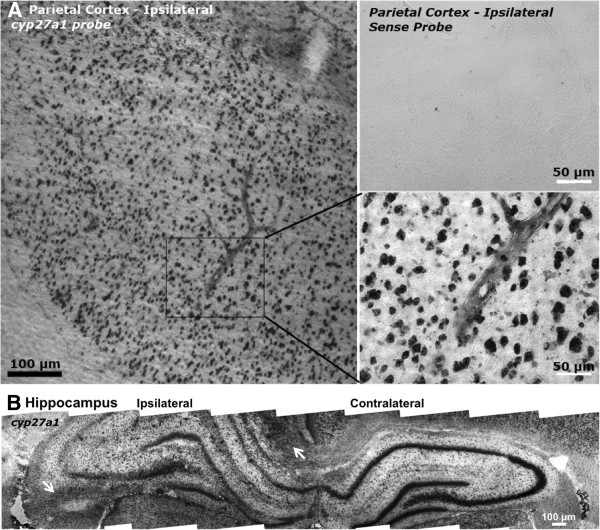
In situ hybridization histochemistry for rat Cyp27a1 mRNA in brain 7 days after TBI. (A) Representative fields of injured parietal cortex with higher magnification of negative control sense probe in the same region of a different section (top inset) and neuronal staining with a large vascular profile (bottom inset). (B) Composite showing injured and contralateral hippocampal Cyp27a1 mRNA with ablation of neuronal staining, as well as heavier non-neuronal staining ipsilateral to injury. Some intense white matter staining is visible medially in the corpus callosum and the ipsilateral hippocampal fimbria (arrows). See Figure 1 legend for methodologic details.